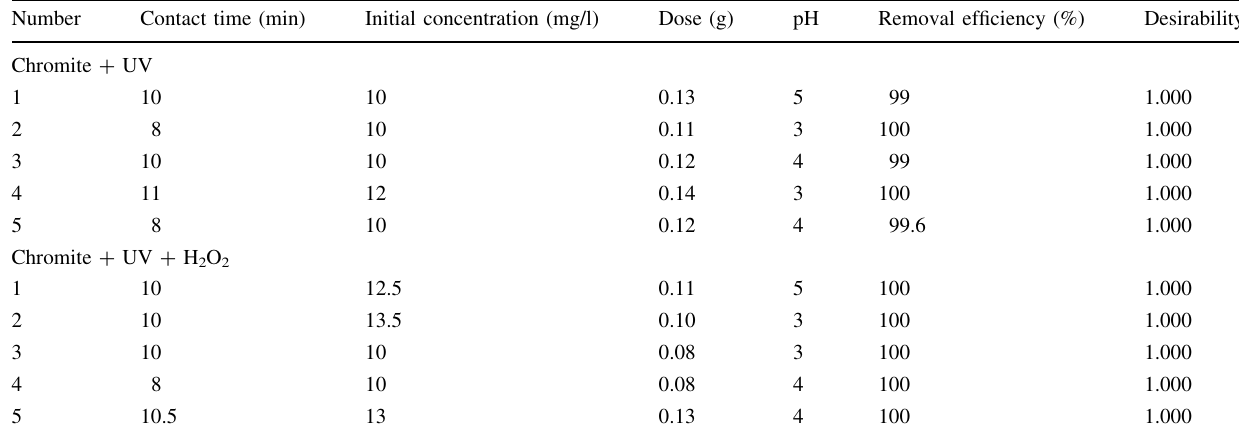
Table 5 The suggested solutions for the maximum removal of Congo red dye using Chromite and Chromite ? H 2 O 2 Number Contact time (min) Initial concentration